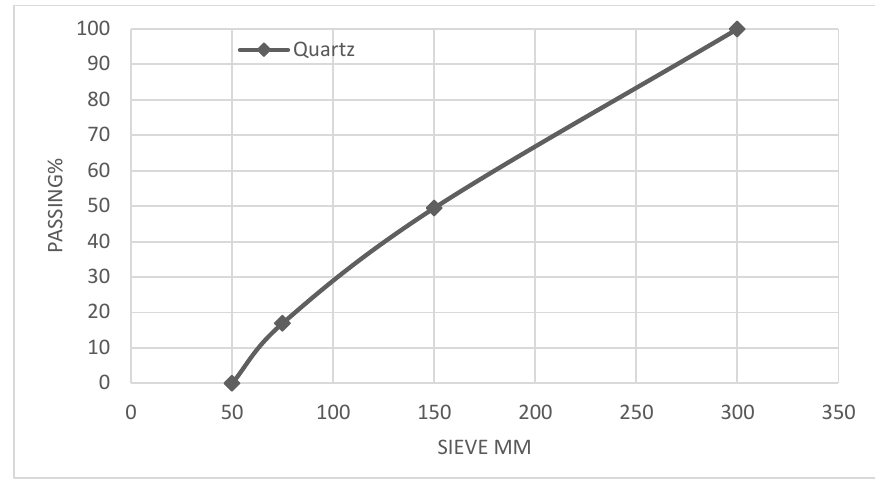
Fig. 1. Particle size distribution of quartz stone powder.